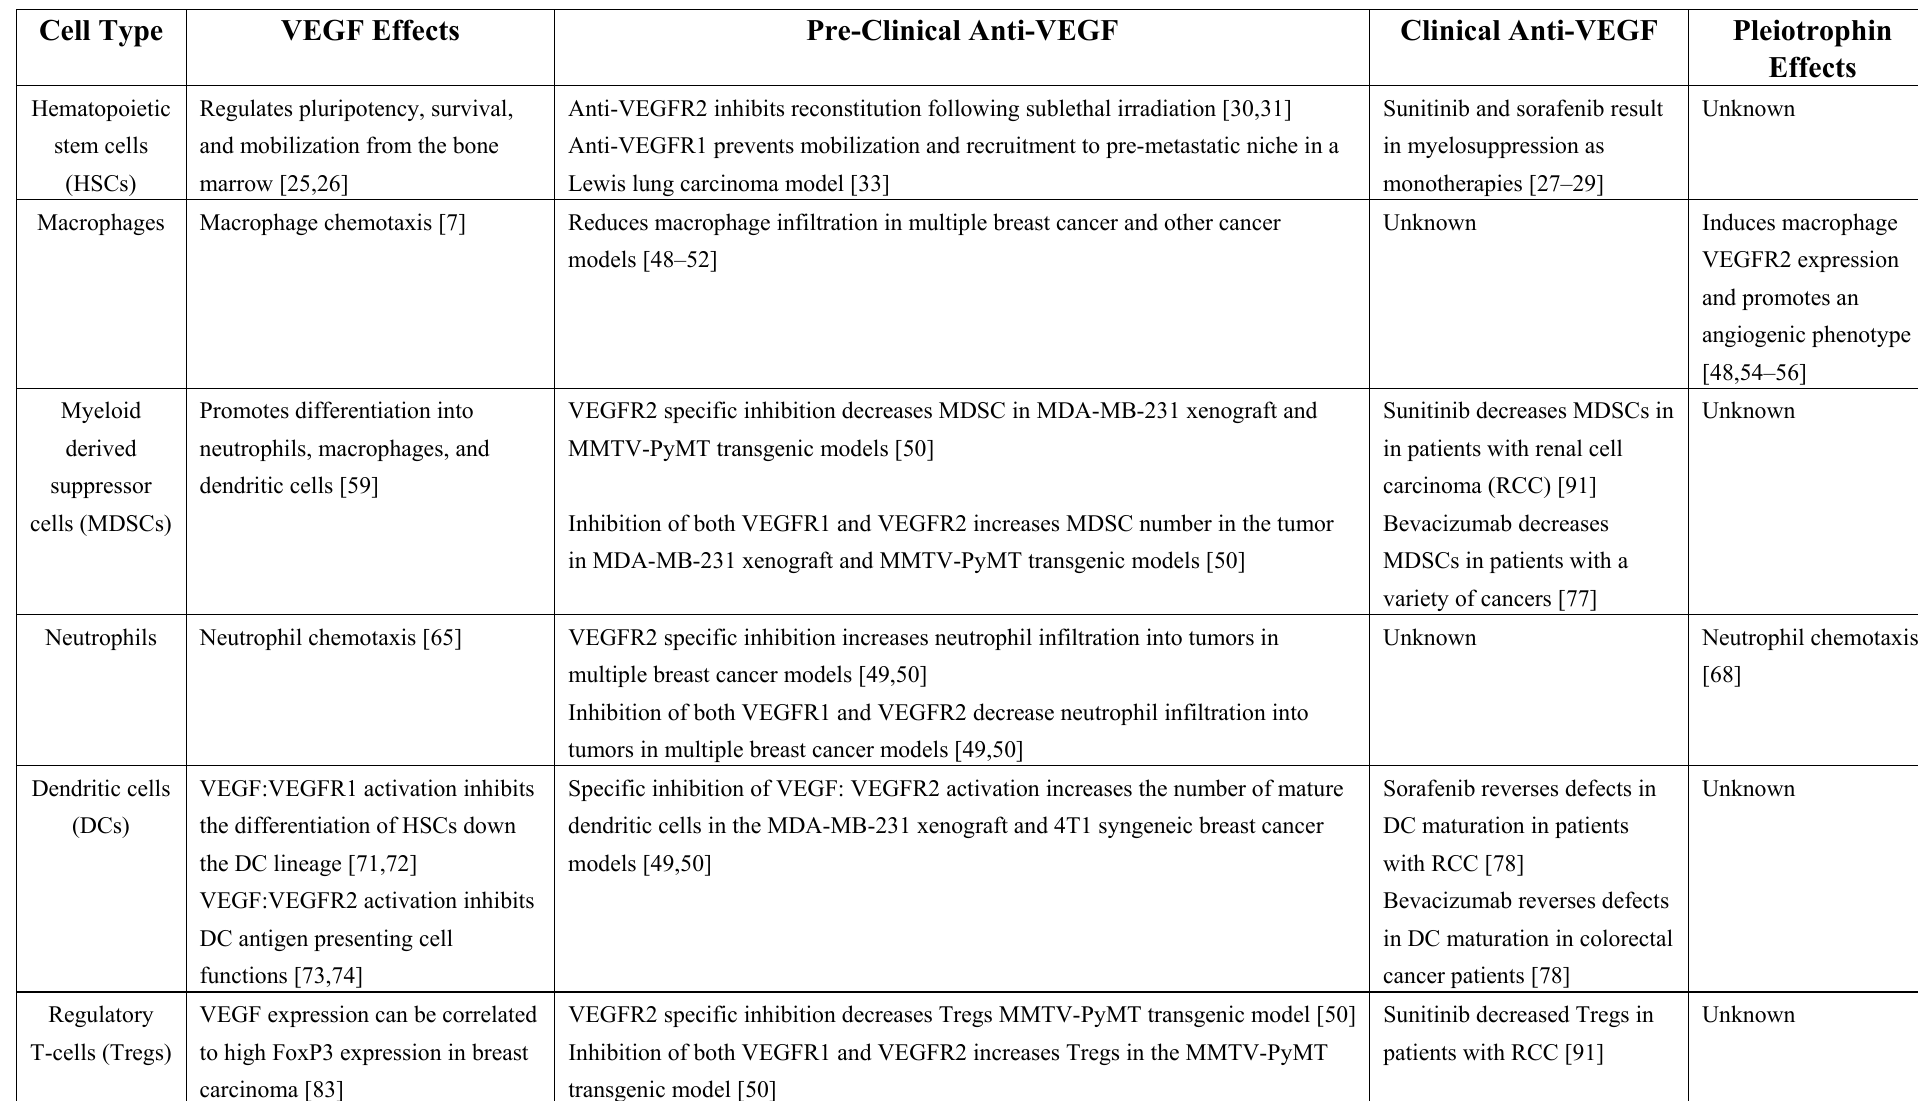
Table 1. Summary of the effects of VEGF, pleiotrophin, and pre-clinical and clinical anti-VEGF therapy on the immune profile. Cell